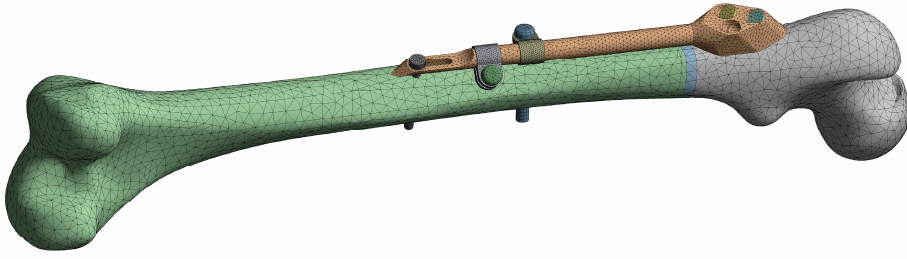
Figure 5. Finite element (FE) model of the femur – SIF assembly.